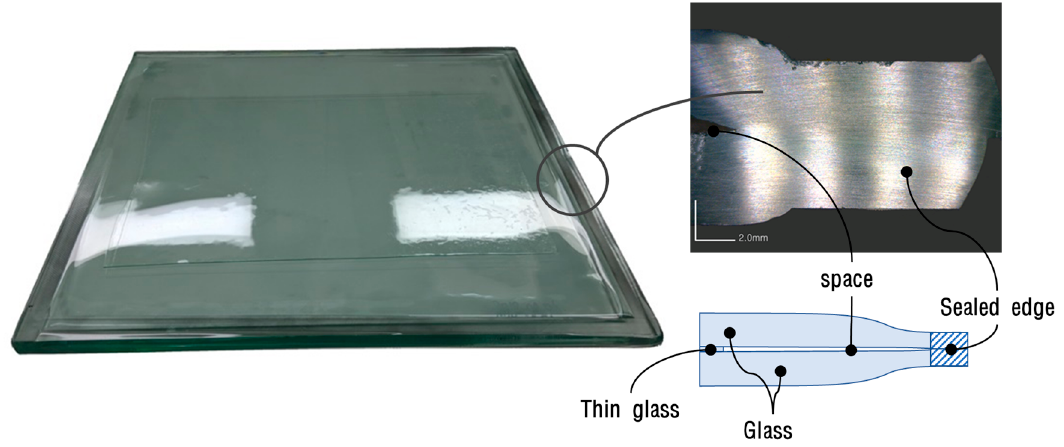
Figure 12. Schematic illustration of the experimental setup used for glass edge-sealing.